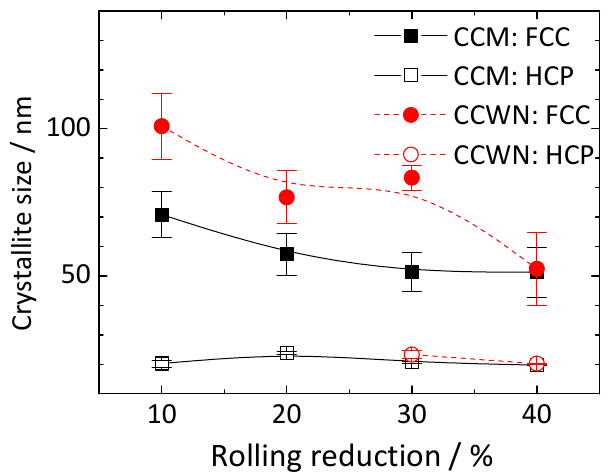
Figure 10. Variations in crystallite size of the FCC and HCP phases in the CCM and CCWN alloys.